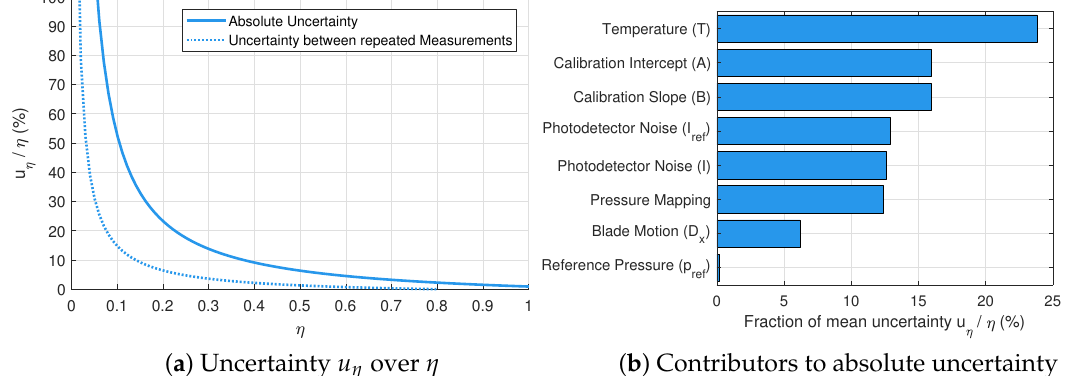
Figure 5. Measurement uncertainty u η